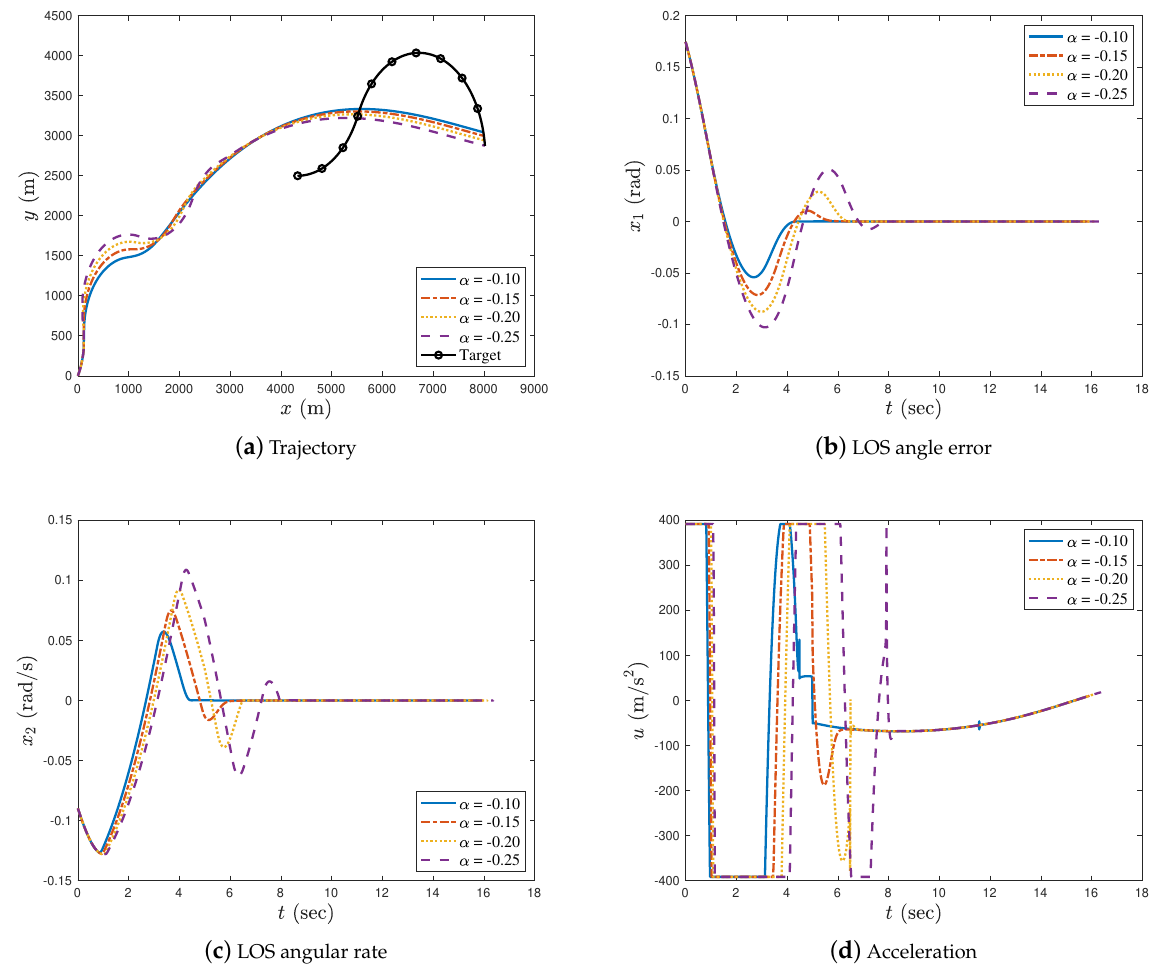
Figure 6. Simulation results with α = 0.25, − 0.20, − 0.15, − 0.10 in case